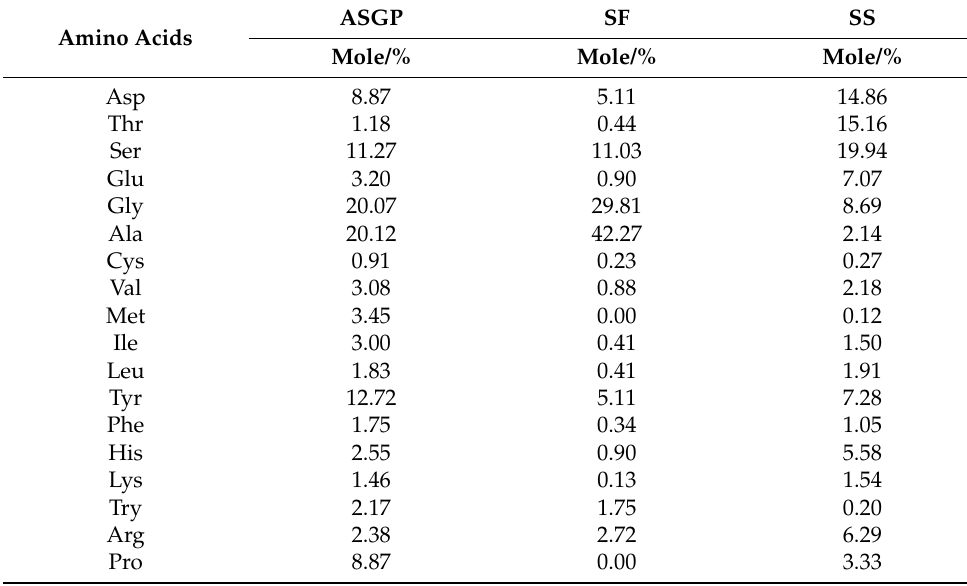
Table 1. Amino acid composition of ASGP, SF and